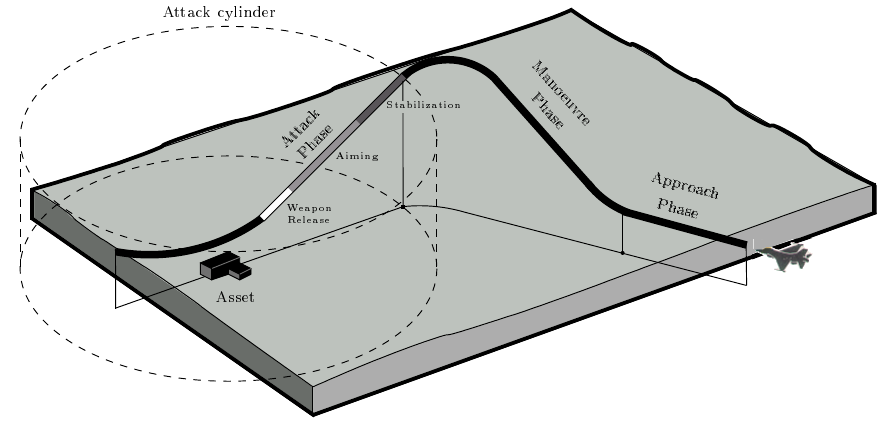
Figure 2: The combat hump dive attack